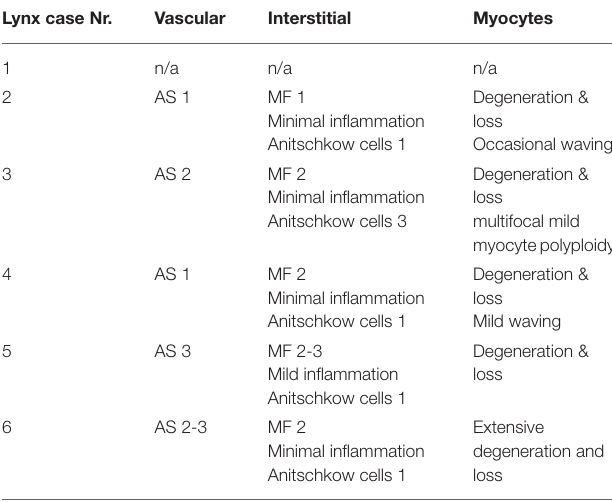
TABLE 3 | Assessment and scoring of the main histopathological features of the heart of six free-ranging Eurasian lynx (subspecies Lynx lynx carpathicus ) from Switzerland affected by cardiomyopathy. Lynx case